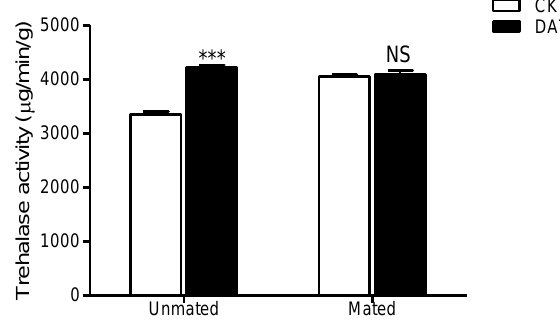
Figure 7. The trehalase activity of males was determined in the CK group (at 19 h after emergence) and DAT group (males treated with 0.01% diallyl trisulfide for 7 h at 12 h after emergence) both before and after mating. The data in the figure are presented as the mean ± SEM. Asterisks depict significant differences relative to the control treatment (NS, no significant difference, ***, p < 0.00). Table 1. Changes in main energy substances between pre- and postmating in CK males (19 h after emergence) and DAT males (treated with 0.01% diallyl trisulfide for 7 h at 12 h after emergence). Significance of ∆CK ∆DAT F df p Glycogen −7.11 ± 0.63 −8.94 ± 0.92 Total soluble sugar 37.36 ± 2.08